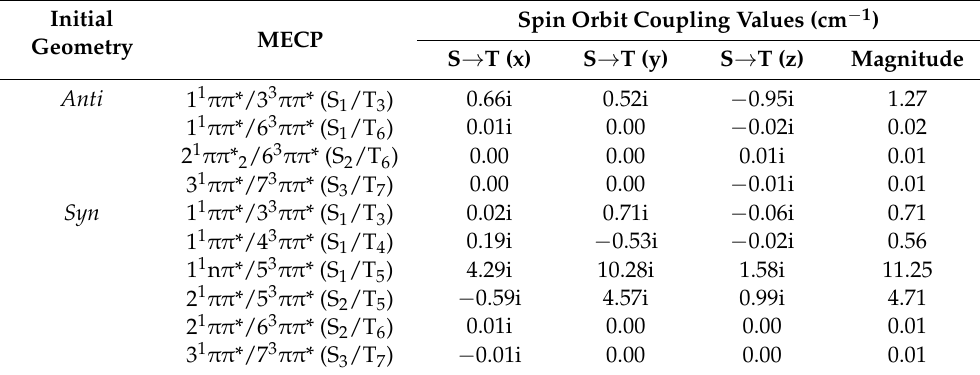
Table 1. Spin-orbit couplings between singlet and triplet states of p -HMC calculated at MECPs found by optimising geometries from both the anti and syn conformer FC points. Matrix elements for the x, y and z components (all imaginary) given along with the